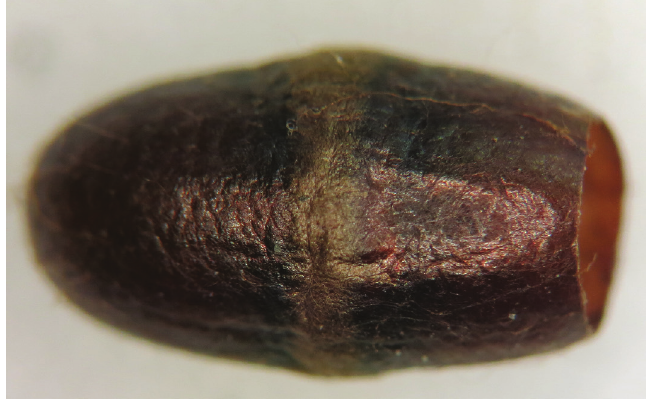
Figure 3. Heinrichiella obscura comb. n., vacated cocoon (Netherlands).